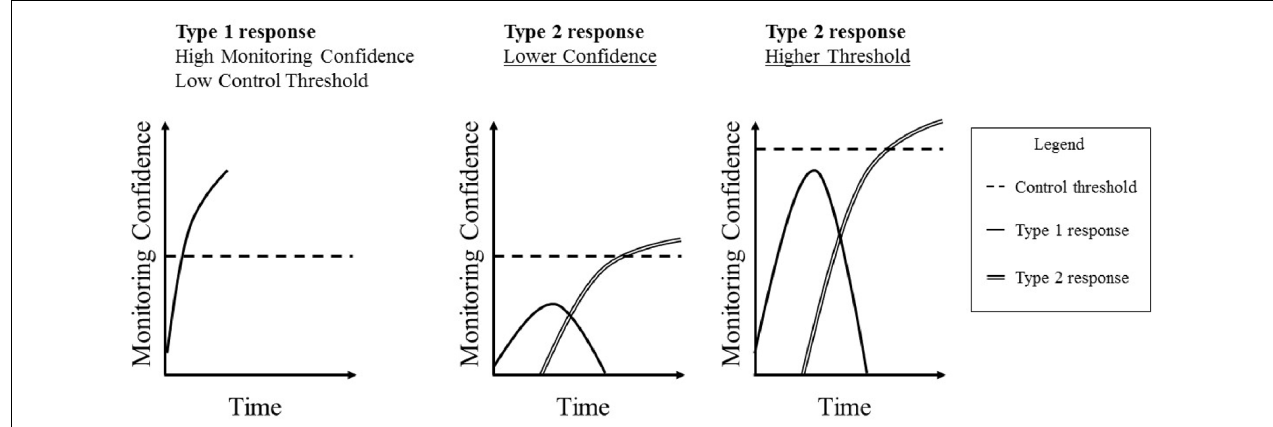
FIGURE 3 | Examples of how monitoring confidence accumulates toward a control threshold over time leading to a Type 1 or Type 2 response.